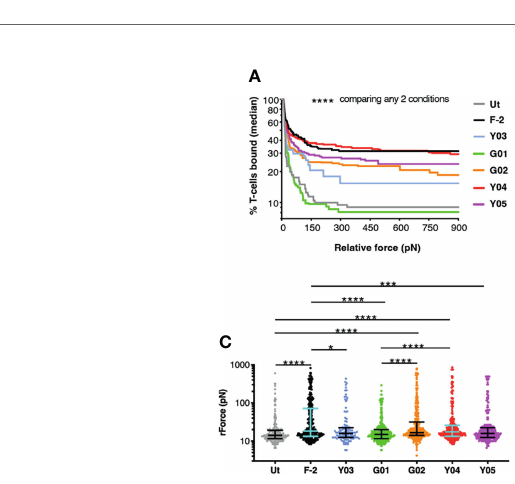
FIGURE 2 | z-Movi analysis of CAR T-cell avidity for CD19 + LO68 tumor cells. (A) T-cells were engineered to express the F-2 (CD28+CD3 z ) CAR or 2G CAR derivates that contain a mutation in V H CDR3 region. After fl ow sorting to purity, CAR T-cells were incubated on CD19 + LO68 tumor cells within a z-Movi micro fl uidic chip. Increasing acoustic force was applied and the median percentage of bound T-cells was determined over time. Statistical analysis was performed using a Kruskal-Wallis test, comparing % T-cells bound across the entire force ramp. (B) Avidity score represents the ratio of the mean relative force (rForce) per cell required to detach T-cells from the target CD19 + LO68 tumor monolayer, compared to untransduced (Ut.) T-cells (median + interquartile range, n=3-4 repeats from 2 independent donors). (C) Dot plot represents the rForce per cell required for detachment from the target cell monolayer. For clarity, a single representative run for one healthy donor is plotted in which each dot represents a single cell. Bars indicate median and interquartile range. Collectively, these dots generate the avidity curve shown in (A) , meaning that all avidity curves are built with >1000 single cell observations per donor. Statistical analysis was performed using a Kruskal-Wallis test. (D) Bar plot depicting the percentage of T-cells bound to the target cell monolayer after applying a minimal rForce (210 pN) required to detach a median of 90% untransduced (Ut.) T-cells (mean ± SEM of n=11 analyses incorporating 3 different healthy donors). Statistical analysis was performed using two-way ANOVA. **** p < 0.0001; *** p < 0.001; ** p < 0.01; * p <